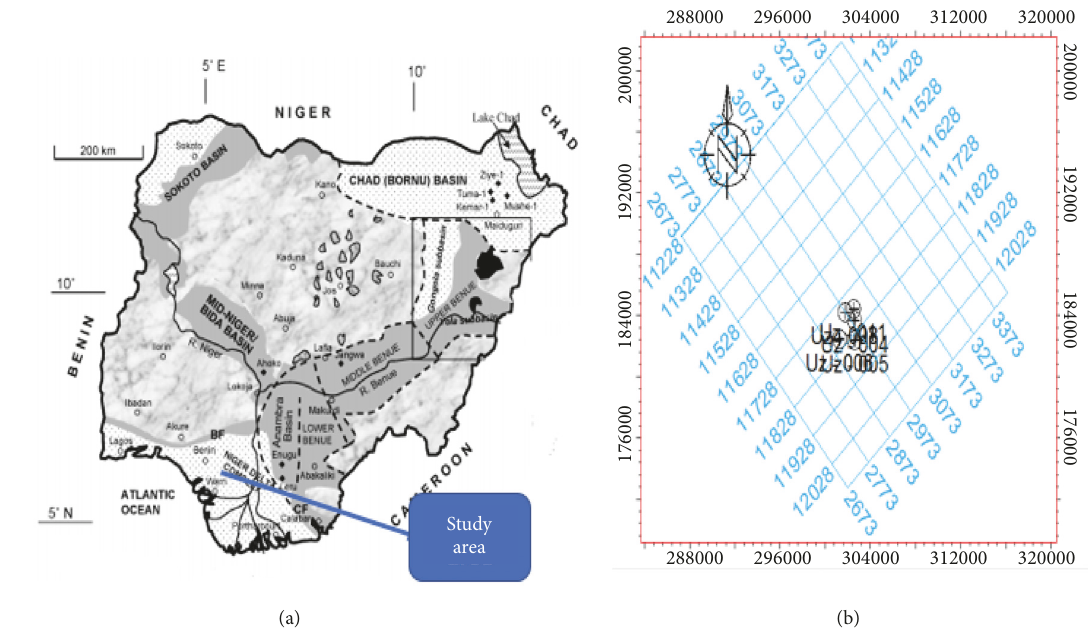
Figure 1: (a) The map of Nigeria showing the location [22] and (b) base map of the study